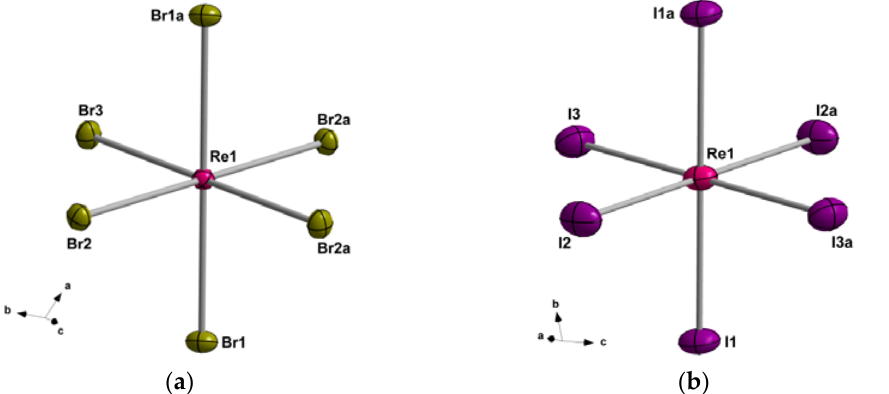
Figure 1. Perspective view of the [ReBr 6 ] 2− and [ReI 6 ] 2− anions of the compounds 1 ( a ) and 2 ( b ). The PPh 4 + cations have been omitted for clarity. The thermal ellipsoids are depicted at the 50% probability level. Table 1. Summary of the crystal data and structure refinement parameters for 1 and 2 .